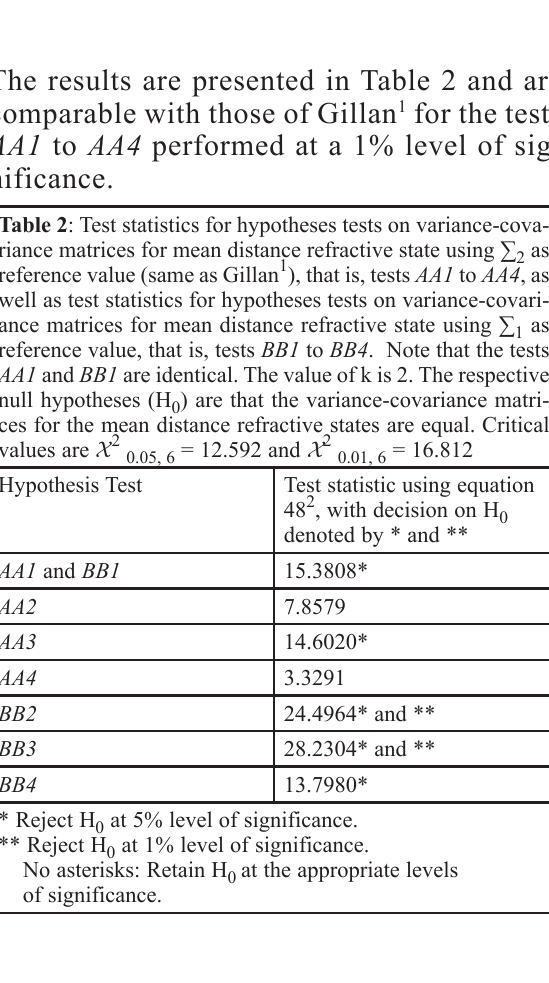
Table 1 : Data modified from Gillan 1 . The variance-covari- ance matrix for vector h (vector h is indicated in Table 4) is shown for each data set collected. BM1: Data collected 30 minutes prior to instillation of Mydriacyl into the right eye of the subject, BM2: Data collected just prior to instillation, AM1: Data collected 15 minutes post instillation, AM2: Data collected 30 minutes post instillation and AM3: Data collected 60 minutes post instillation. All quantities have units D 2 .